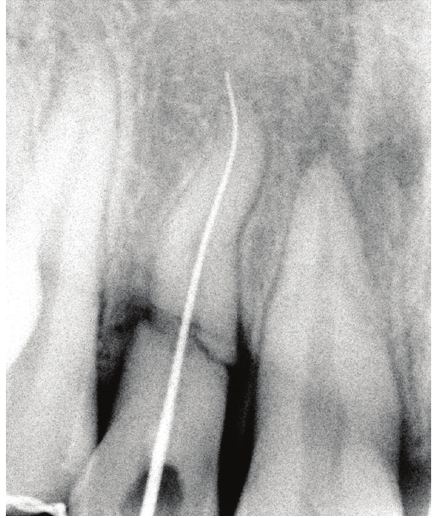
Figure 16: Working length 12.